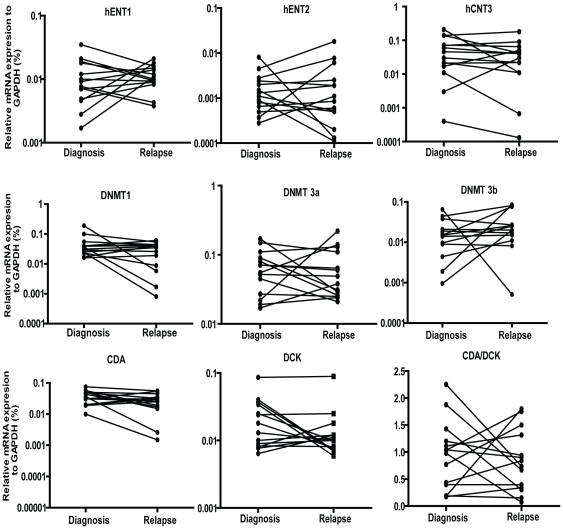
DAC metabolism gene expression in secondary resistance.mRNA expression of hENT1, hENT2, hCNT3, DCK, CDA, MDR1, DNMT1, DNMT3a, and DNMT3b were measured by quantitative real-time PCR between 14 MDS patients at diagnosis and after relapse. GAPDH was used as an internal control. Statistical analysis of the difference of gene expression was performed by paired t test.